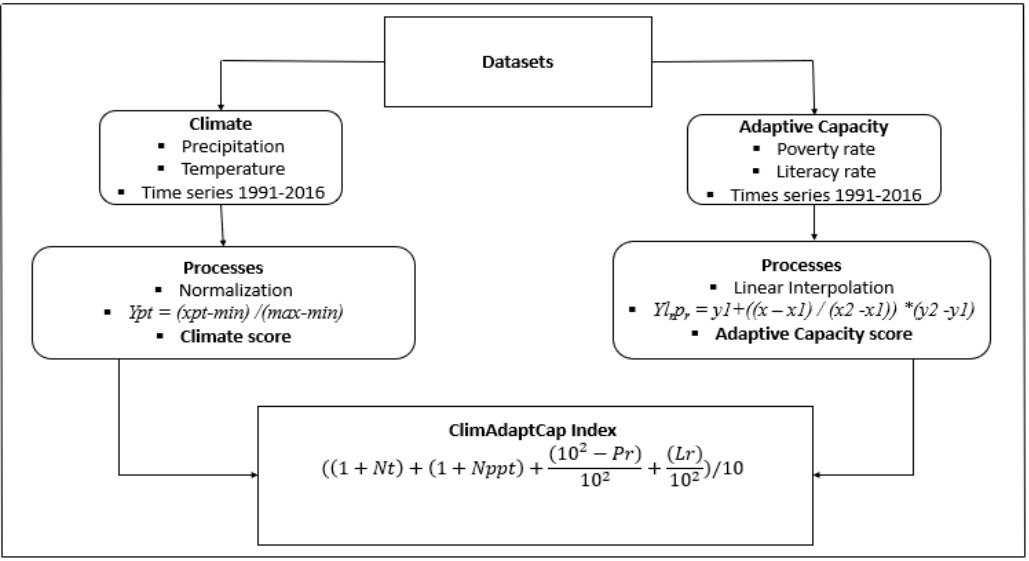
Figure 1. Methodological procedures used in this study. Source: author’s conceptualization.